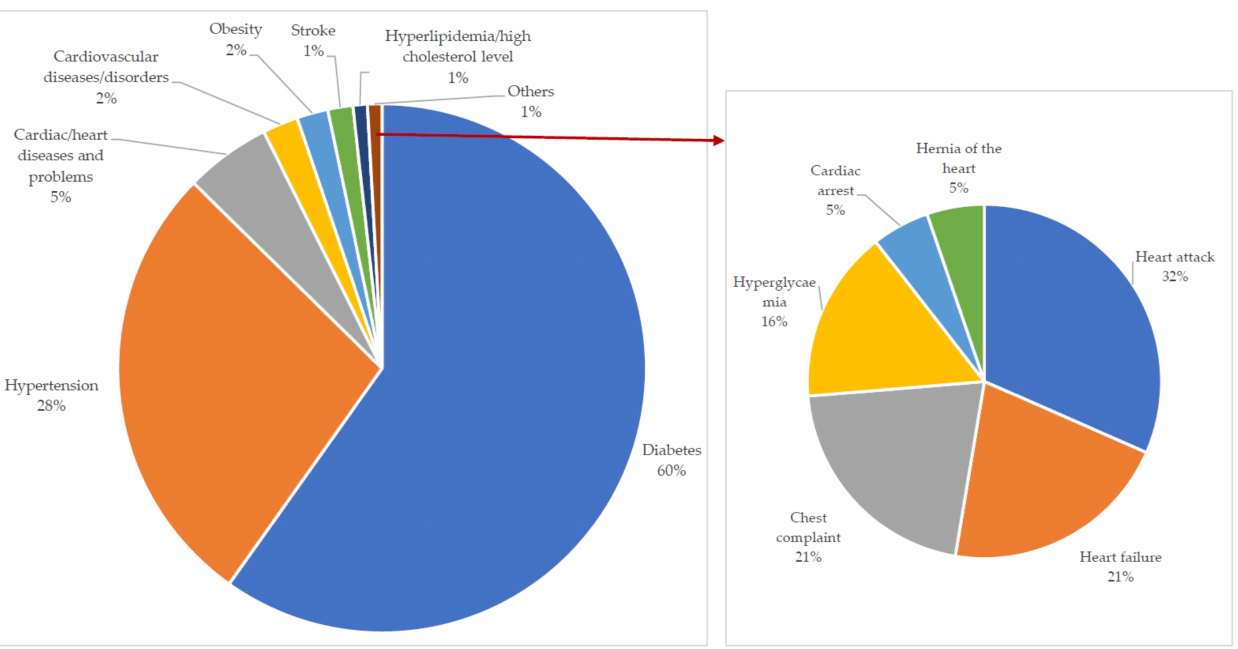
Figure 6. Percentage of cardiovascular diseases and their related risk factors treated with medicinal plants in sub-Saharan